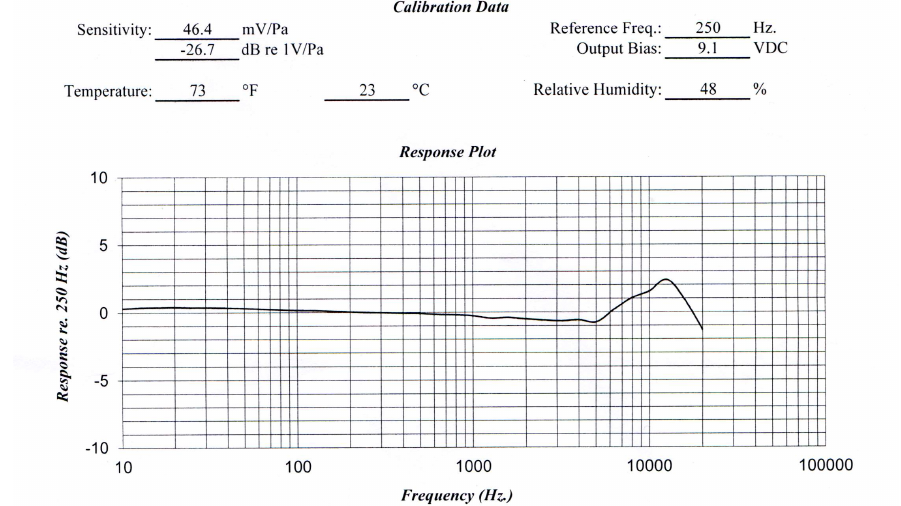
Figure 4. Extract from the calibration sheet of the PCB ICP microphone used during the testing campaigns.